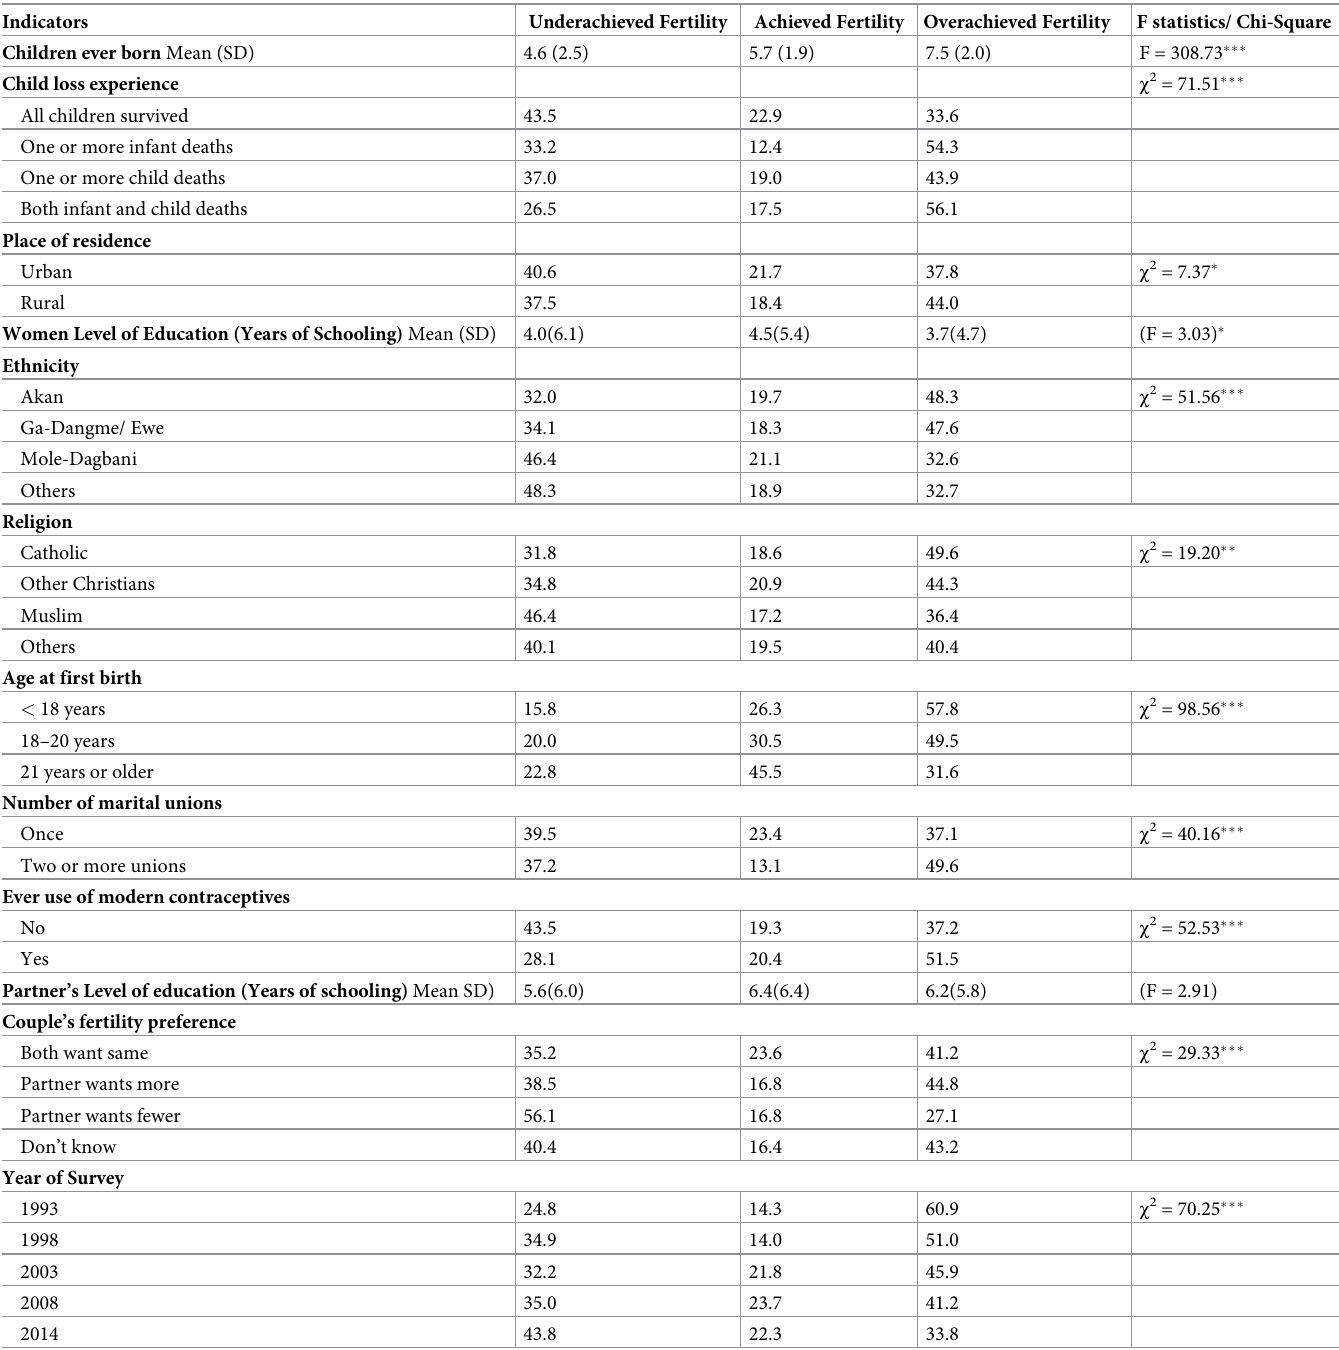
Table 1. Associations between independent variables and fertility gap in Ghana between 1993, 1998, 2003, 2008 &